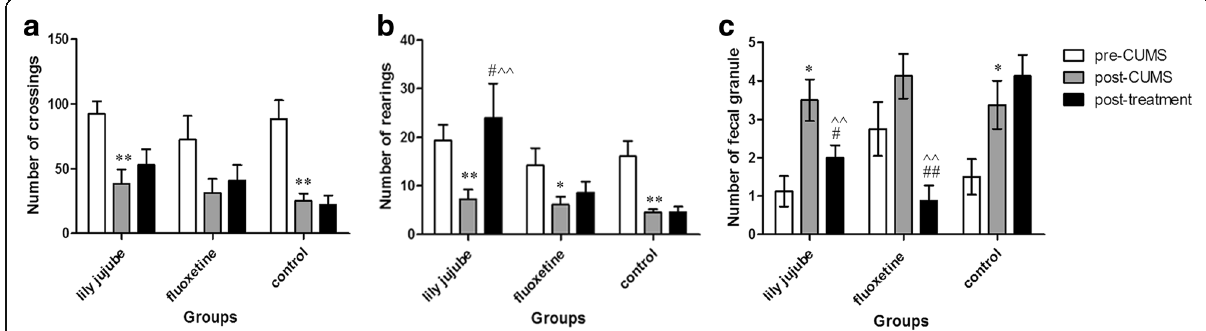
Fig. 5 Changes of parameters in OFT at different time points. a : Number of crossings; b : Number of rearings; c : Number of fecal granule. Note: *< 0.05 compared within group with pre-CUMS; **< 0.01 compared with the pre-CUMS within the group; # < 0.05 compared within group with post-CUMS; ## < 0.01 compared within group with post-CUMS; ^^<0.01 compared with the control